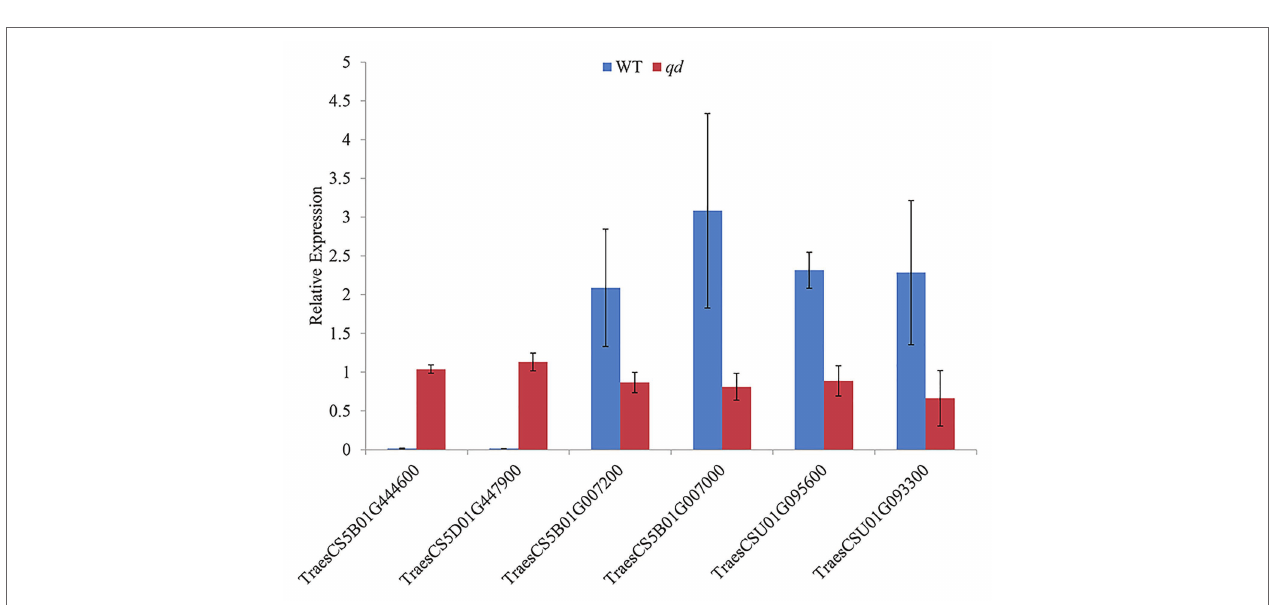
FIGURE 7 | The biosynthesis pathway of benzoxazinoids. The boxes filled with green represent the enzymes containing significantly downregulated DEGs in qd . The box filled with blue represents the enzymes that contained both significantly upregulated and downregulated DEGs in qd . The dotted boxes represent enzymes containing DEUs.